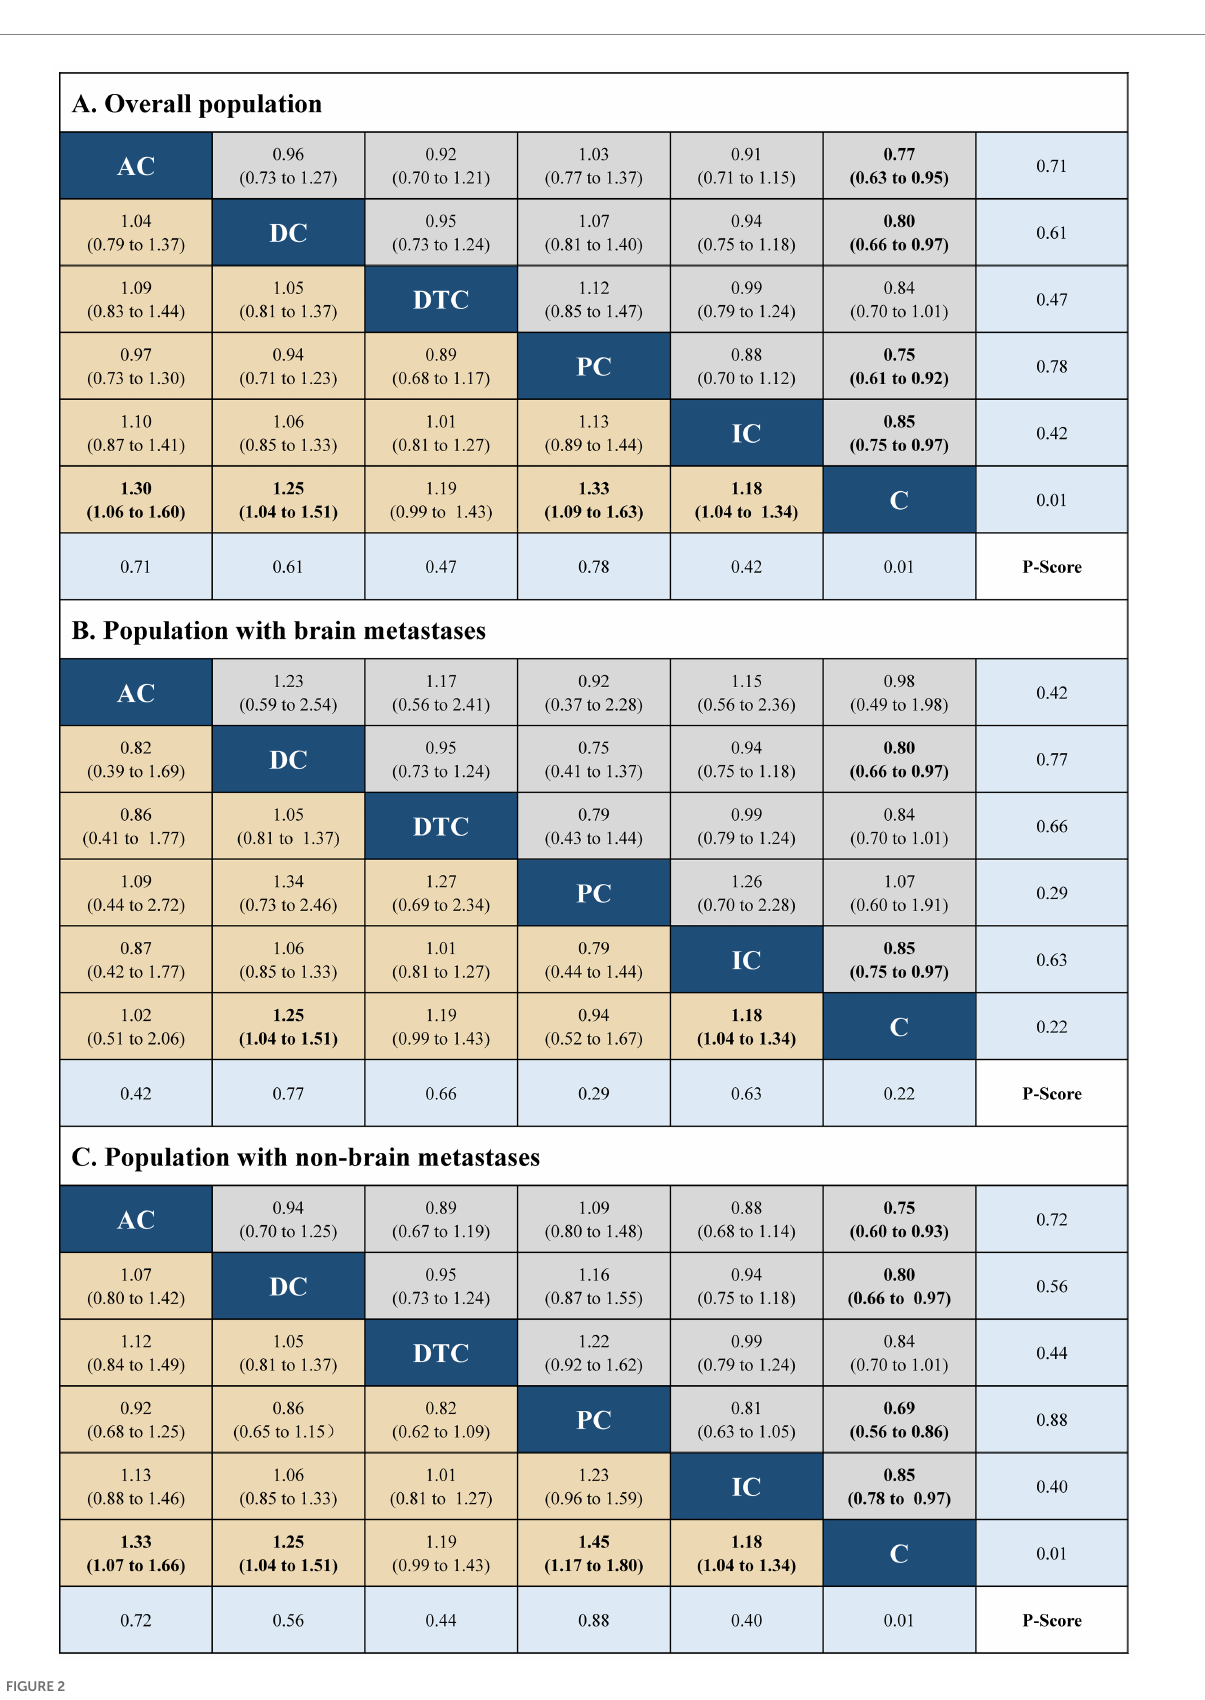
FIGURE 2 Hazard ratios (gray and brown cell) and p-values (blue cell) of the network meta-analysis of the progression-free survival in the overall population (A) , population with brain metastases (B) , and population with non-brain metastases (C) . AC, atezolizumab plus chemotherapy; DC, durvaluma